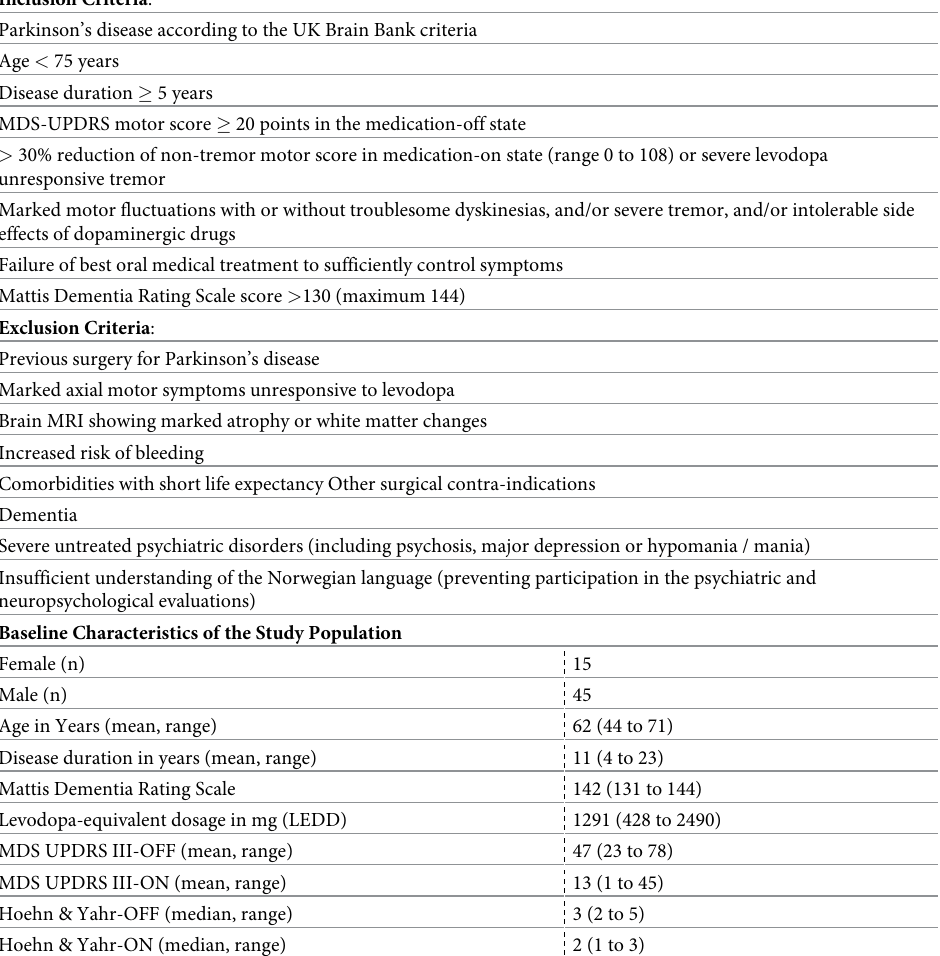
Table 1. Criteria for study participation and baseline characteristics of study population. Inclusion Criteria